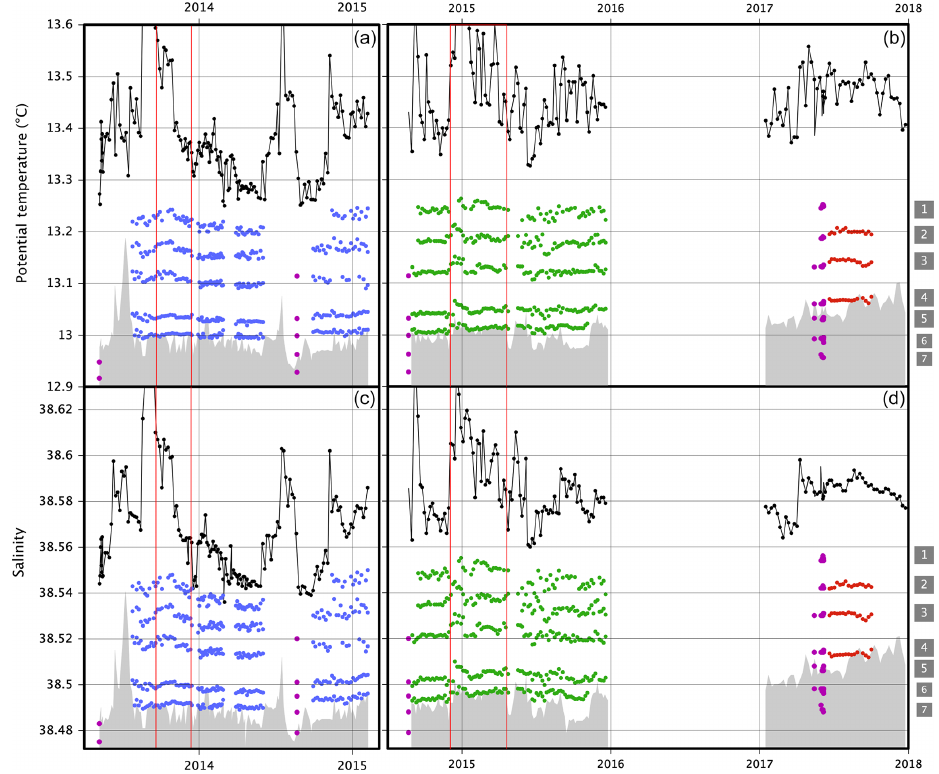
Figure 9. Time series of properties (colored dots) of shipboard and float profiles for detected staircase layers. Temperature is shown in panels (a–b) and salinity in panels (c–d) . LIW properties are indicated by the black lines. The shipboard CTD profiles are indicated in purple and the float CTD profiles in blue (float 6901513), green (float 6901600) and red (float 6902732). Grey shadows indicate the depth ranges below 1000dbar. Time series of floats 6901513 (a, c) and 6901600 (b, d) are represented in different panels to avoid overlapping. The layer numbering for the stations PEACETIME (Table 4) is indicated inside the grey boxes on the right. The two episodes described in the text (Sect. 3.2) are delimited by red vertical lines. Table 5. Lateral density ratios ( R i ; Eq. 3) defined by the changes in temperature and salinity within each layer ( i ). Ratios computed L considering the whole dataset (Fig. 12a), the selection inside the box (37 ◦ 20–38 ◦(cid:48) N, 4–6 ◦ E; Fig. 12b) and the two episodes (Fig. 12c and d). Average values over the five layers also